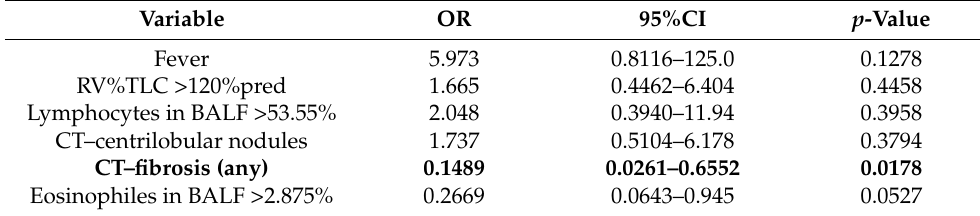
Table 5. Treatment outcome predictors (multivariate logistic regression